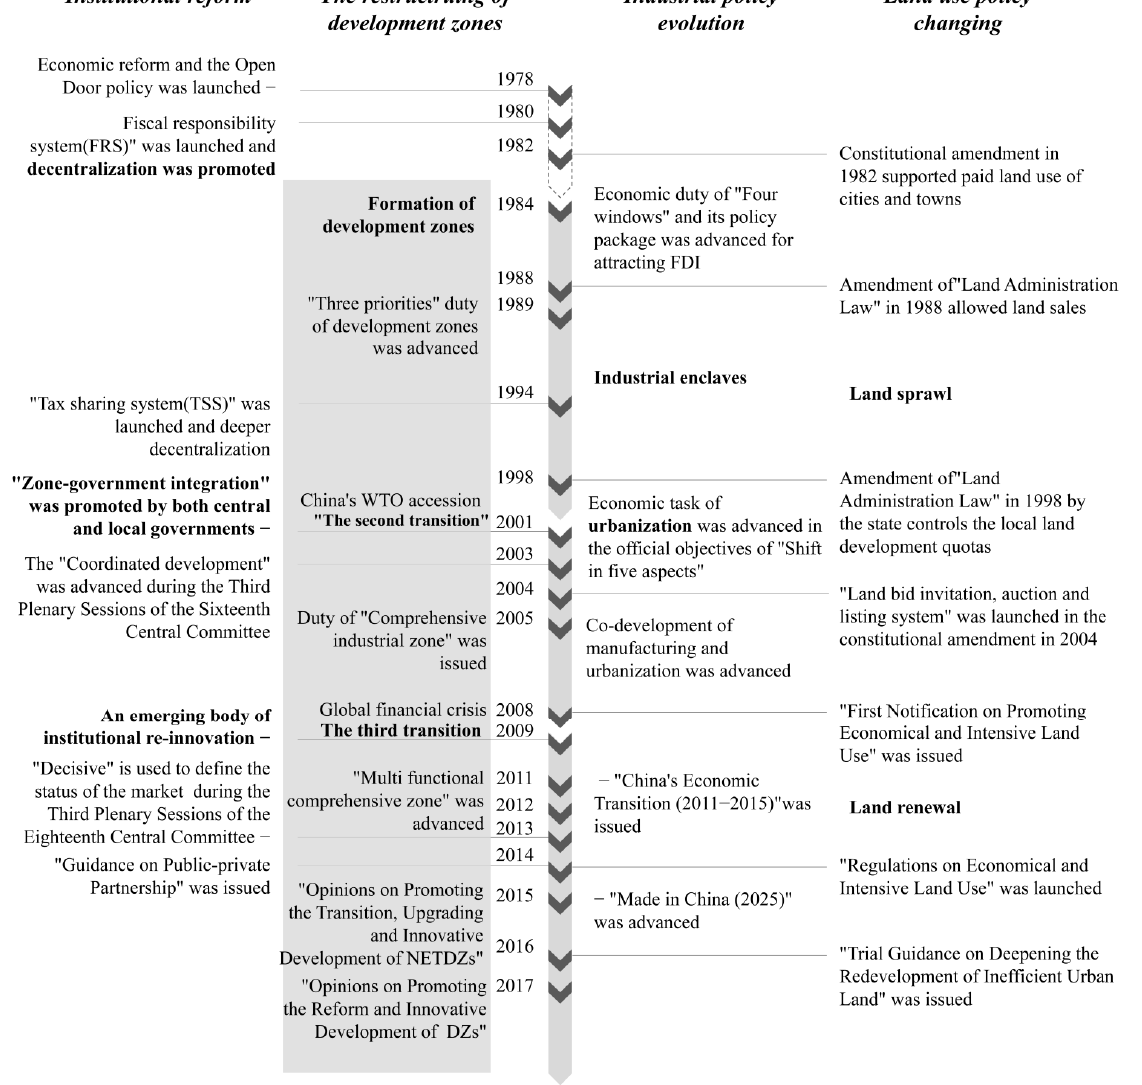
Figure 2. The restructuring of development zones and relevant policy evolution. Source: Prepared by the authors.